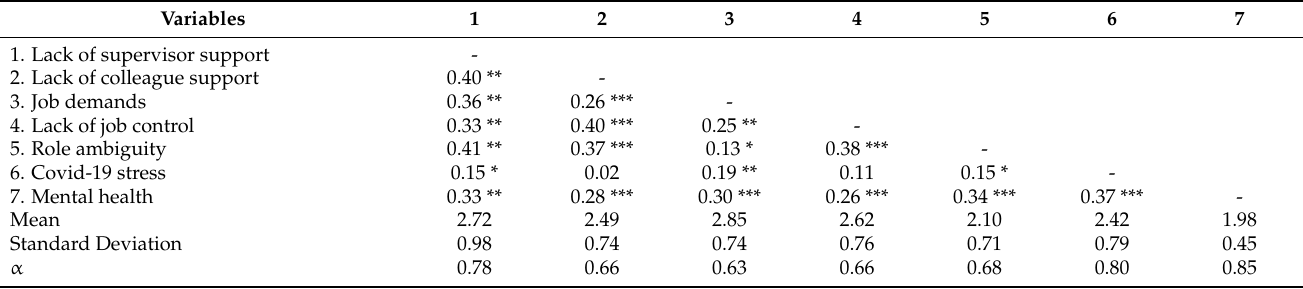
Table 1. Descriptive statistics, Cronbach’s alphas, and correlations between the study variables.